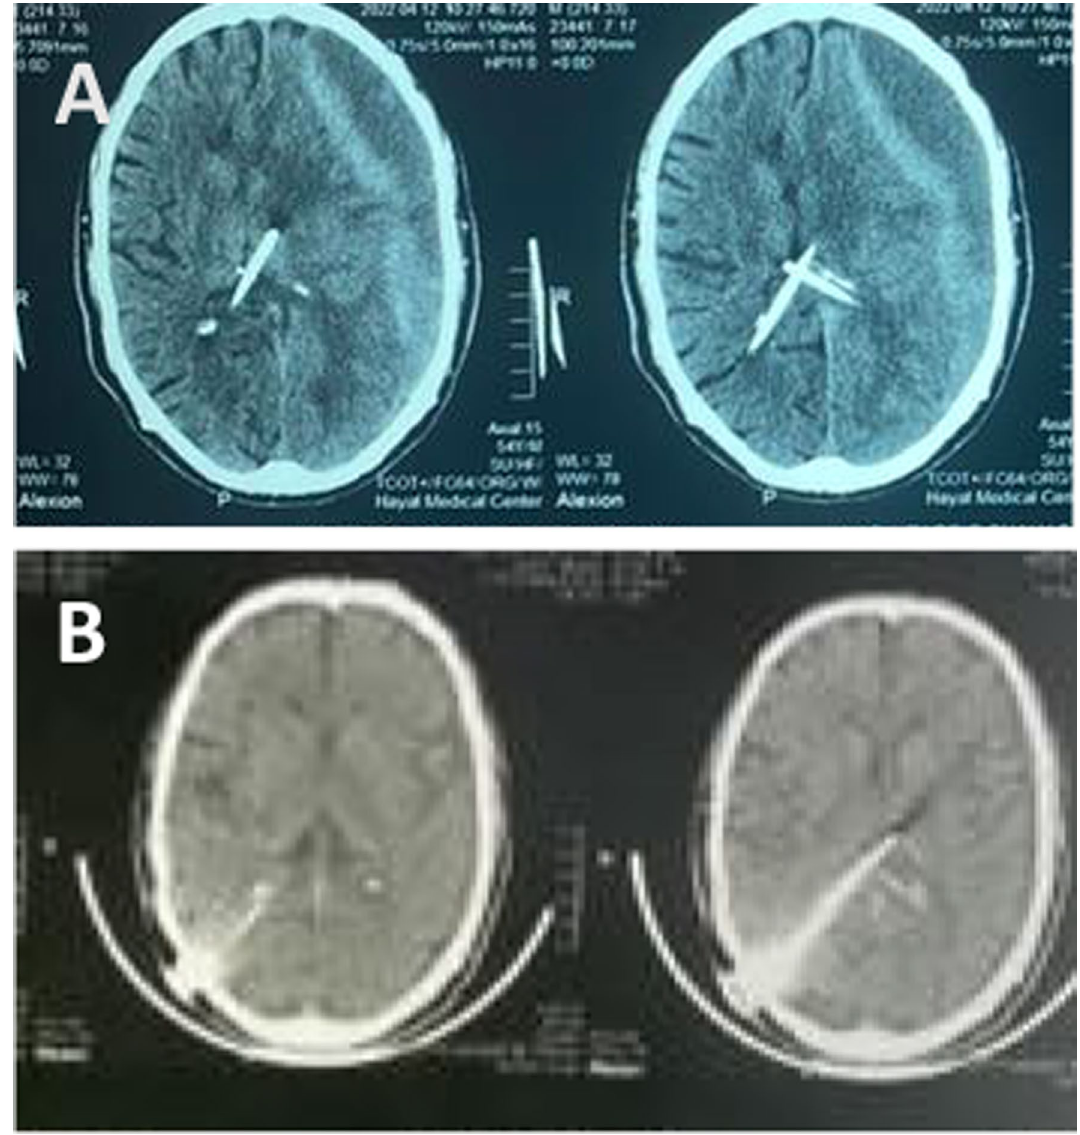
Table 5 refers to number of days after the onset of our protocol where the progress of our patients’ neurologic condition took place and necessitated abortion of the conservative plan to prevent any further deterioration. Table 6A spots the light upon the GCS values for our study subjects who showed a favorable neurological out- come to DXM treatment protocol at the beginning of our treatment protocol and throughout the follow-up